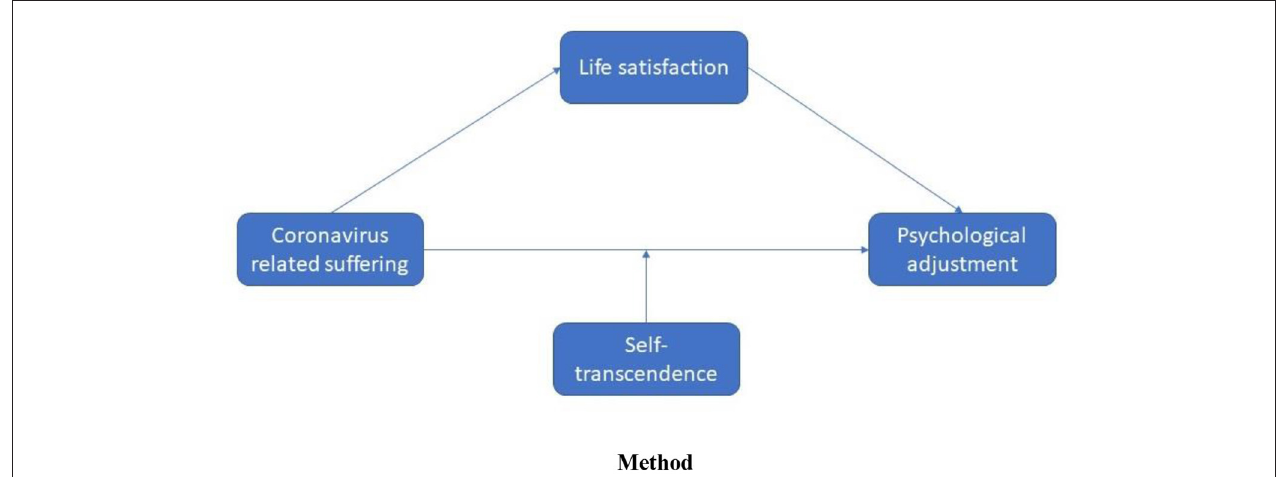
FIGURE 8 | Moderated mediation model demonstrating the association between the variables of the